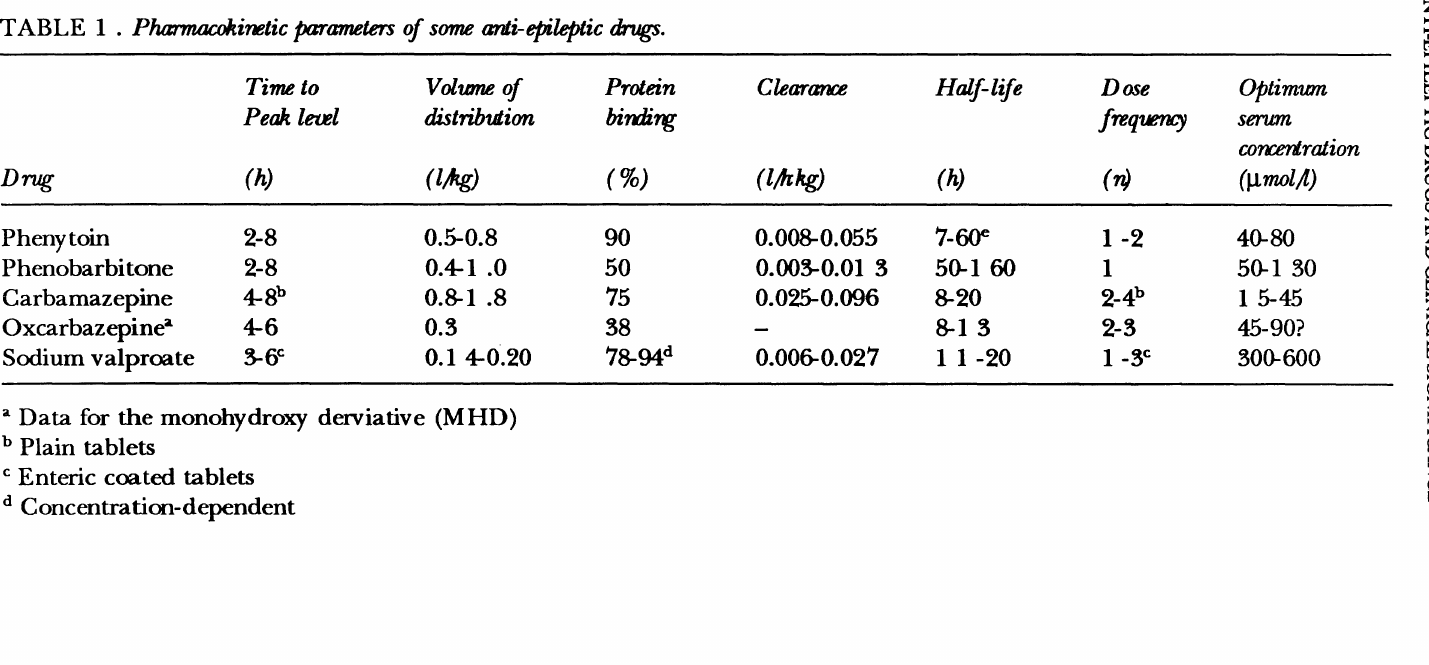
~ - ~ '" C"l corrertration 0 0 CJl